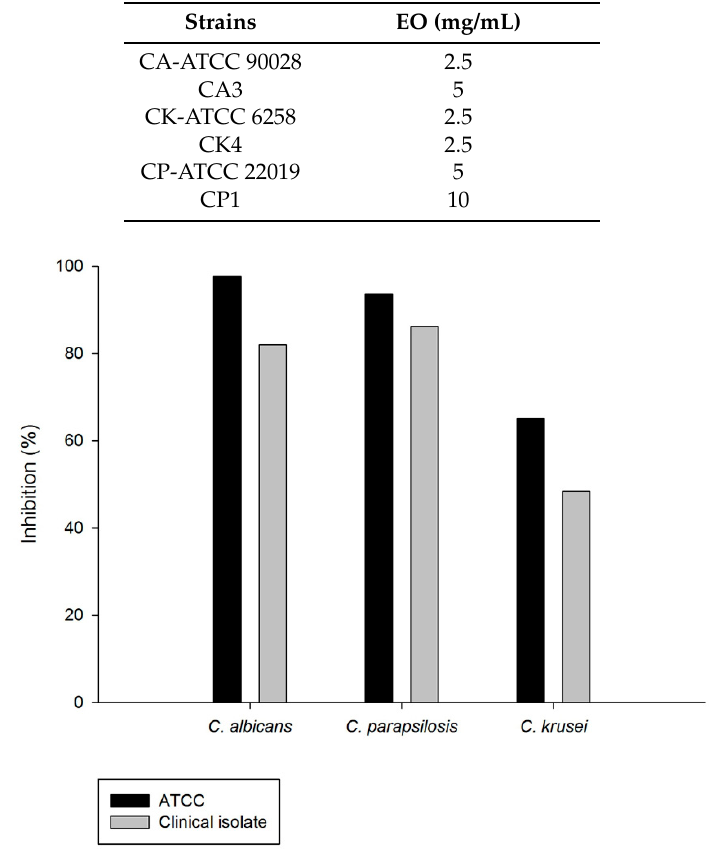
Figure 8. Percentage of inhibition of the essential oil of C. nardus against biofilms of Candida species.